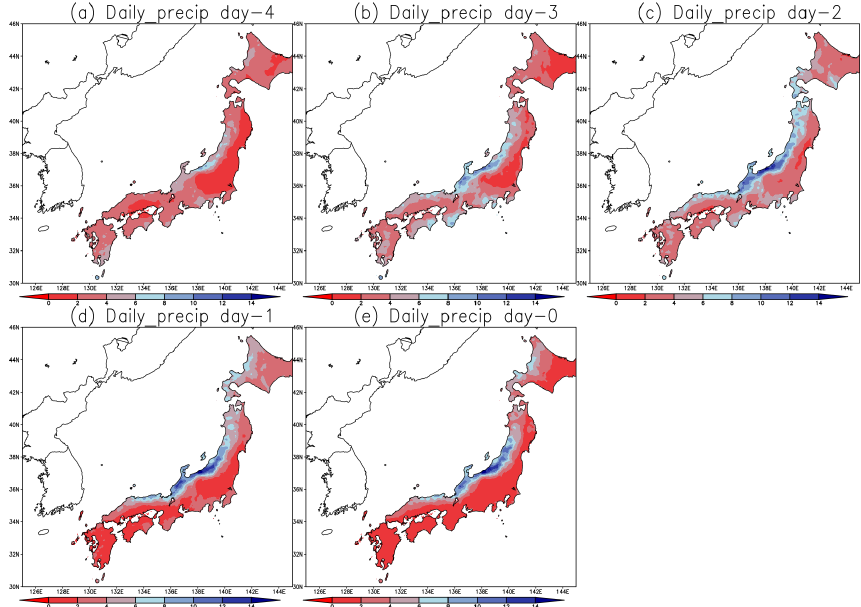
Figure 8. Composite daily mean precipitation (mmd − 1 ) from day 4 to day 0 for 1968/69–1979/80.